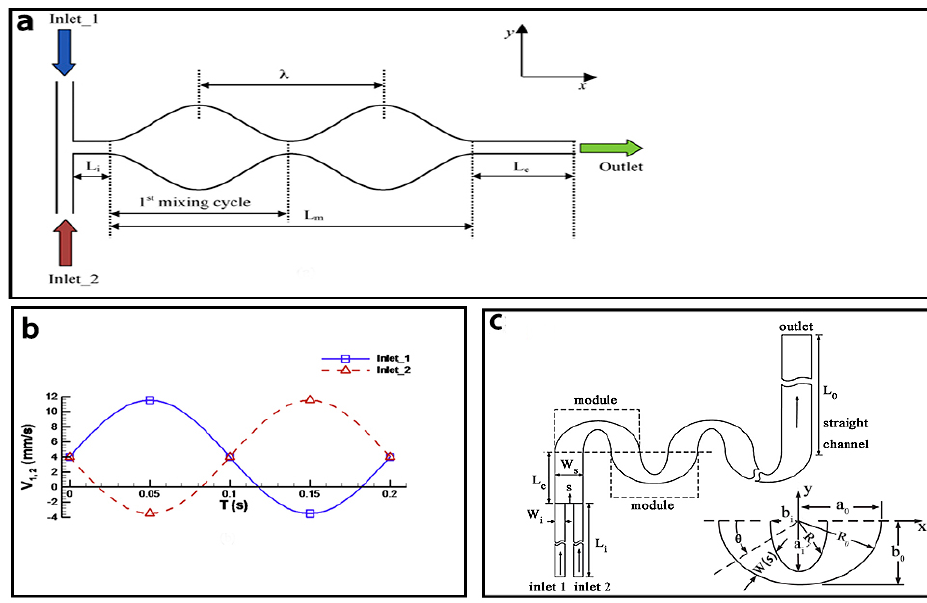
Figure 14. ( a ) Schematic of the convergence-divergence based micromixer; ( b ) The inlet flow velocities of the convergence-divergence based micromixer; ( c ) Schematic of the convergence-divergence based micromixer with meandering channel. Reproduced with permission from [102,136].